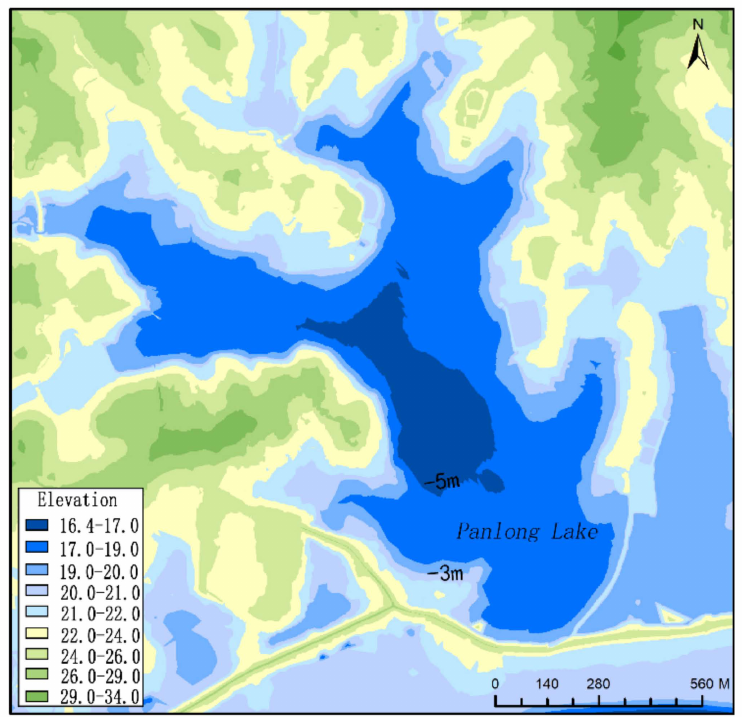
Figure 5. Topographic map of Panlong Lake obtained after the survey and data